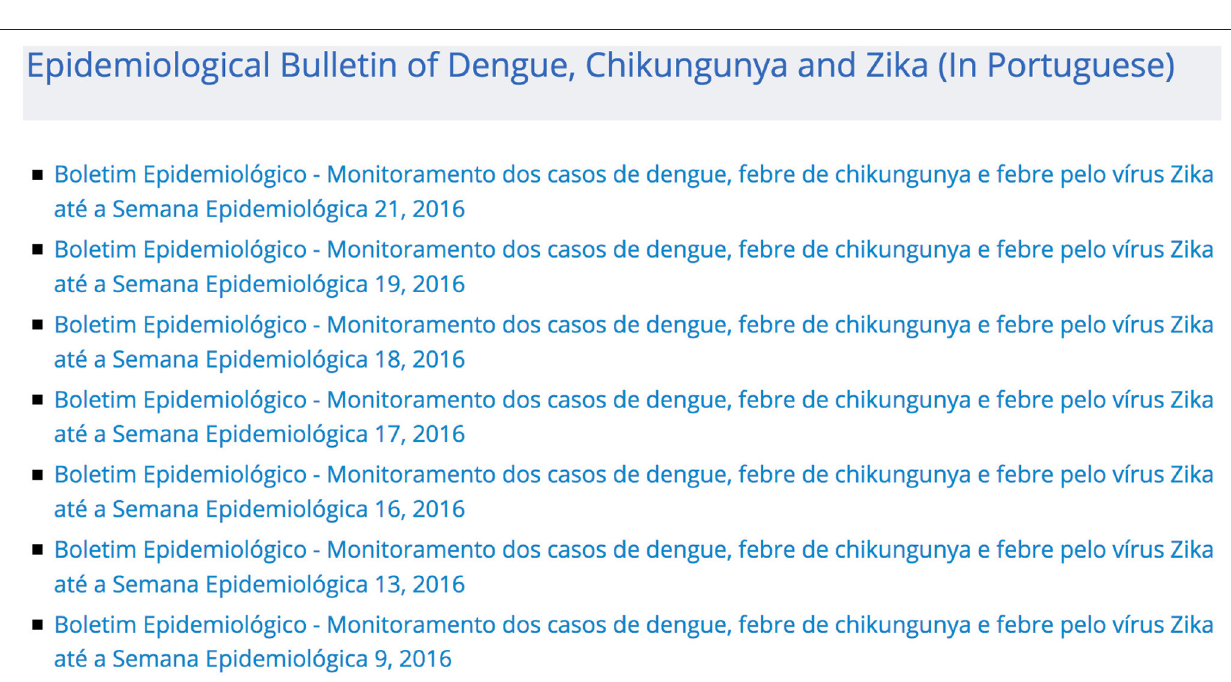
FIGURE 2 | Screenshot showing part of the mosquito-borne illness epidemiological bulletin list available at (30). This list only goes through week 21 of 2016 and is missing a number of weeks when compared to the list in Figure 1 . This screenshot was taken at the same time as the one in Figure 1 .